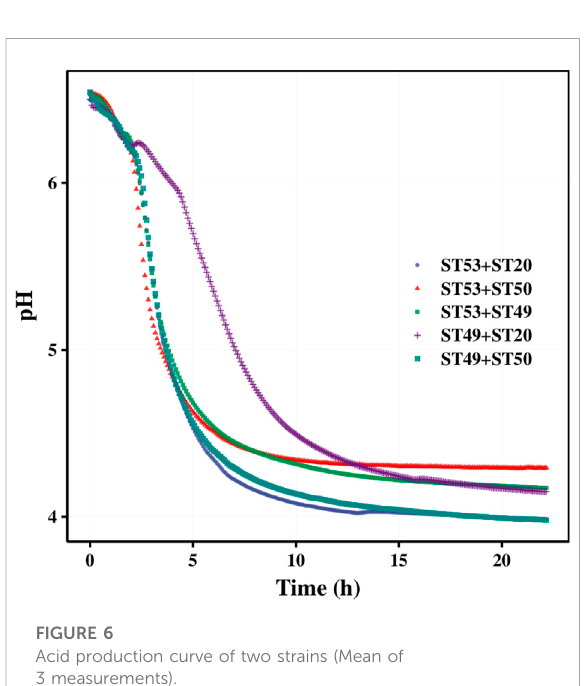
Acid production curve of two strains (Mean of 3